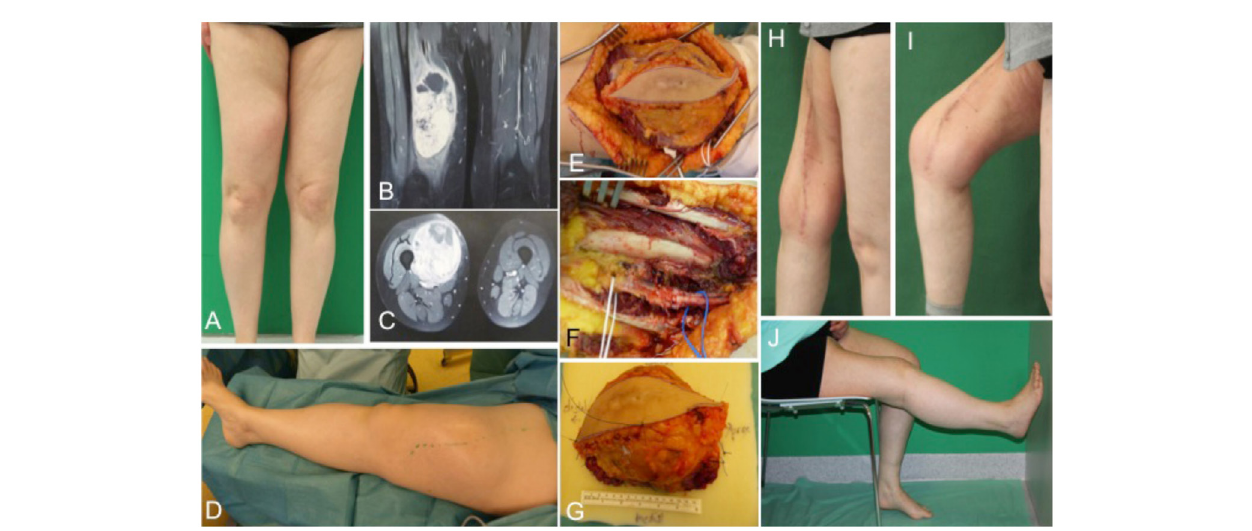
FiGURe 2 | Preoperative clinical presentation of a 54-year-old female with an undifferentiated myxofibrosarcoma G3 in the anterior compartment of ventral thigh and correlation with MRi (A–C) . Intraoperative situs (C–F) with complete tumor removal (G) . Long-term results (H–J) of primary closure showing the esthetic outcome and maintained function of the right